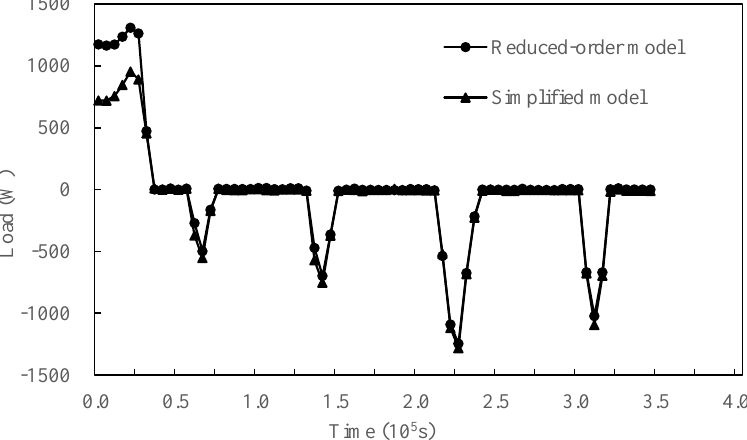
Figure 10. Hourly load between the SM and RM.